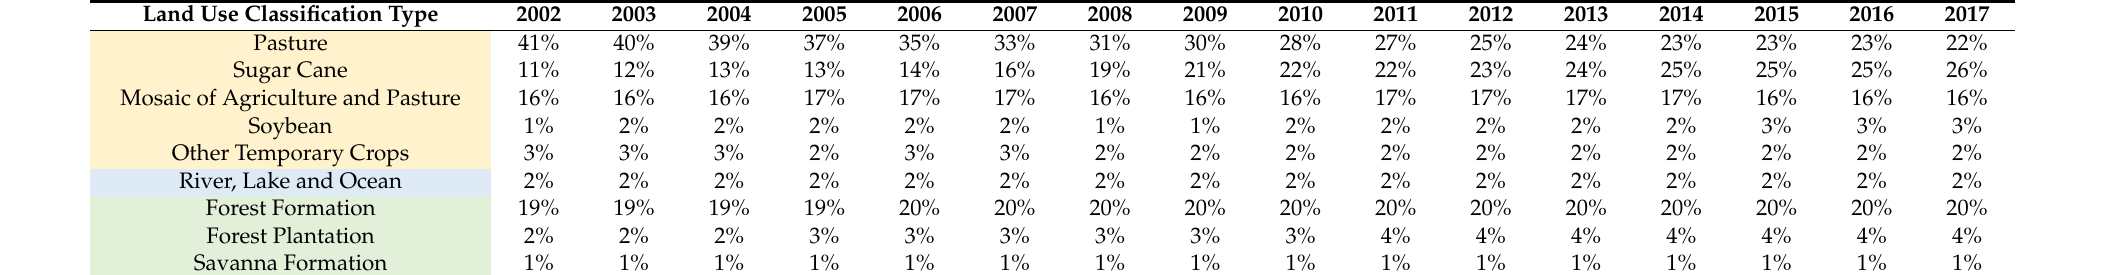
Table 2. Land use in S ã o Paulo, by classification type between 2002 and 2017.